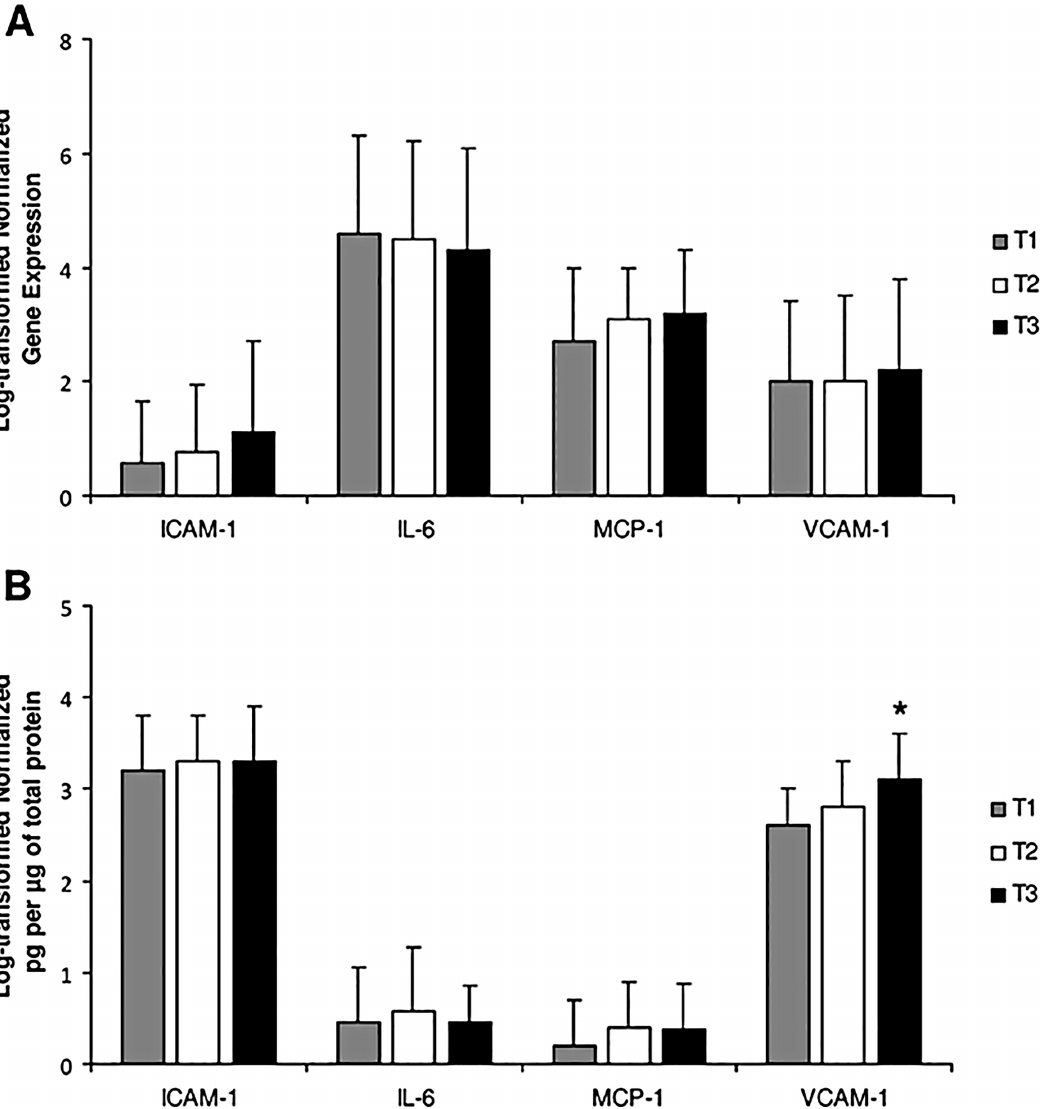
Fig 2. Proinflammatory cytokines, adhesion molecules and c-IMT measurements. A) Differences in the gene expression of proinflammatory markers in the artery wall according to c-IMT tertiles. B) Differences in the quantification of proinflammatory proteins by c-IMT tertiles. * ANOVA test for VCAM-1, P = 0.003; Bonferroni procedure, T3 vs. T1, p = 0.003; T3 vs T2, P = 0.076.